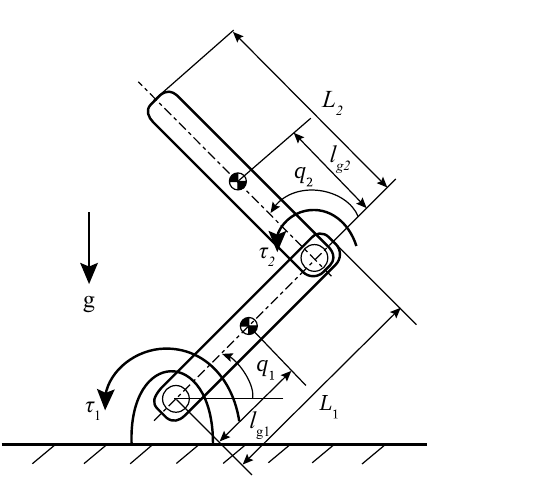
Fig. 4 The two-link robotic manipulator [41]